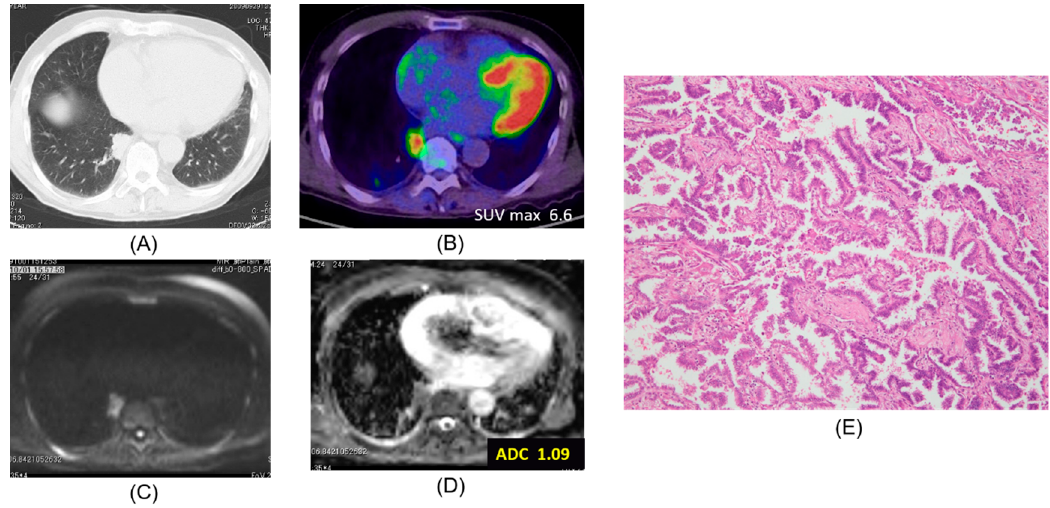
Figure 3. Papillary adenocarcinoma. The ADC of the carcinoma was 1.09 × 10 − 3 mm 2 /s. ( A ) CT, ( B ) PET-CT, ( C ) DWI, ( D ) ADC map, ( E ) Pathology (Hematoxylin and Eosin Staining) ×100.